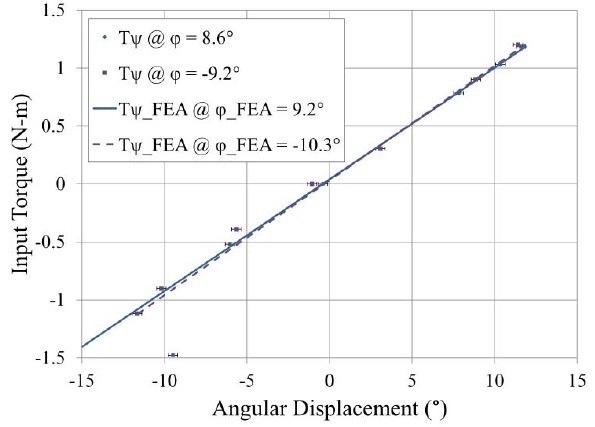
Figure 12. Comparison of measured and predicted input torques ( T ψ ) at two values of φ for the titanium prototype.